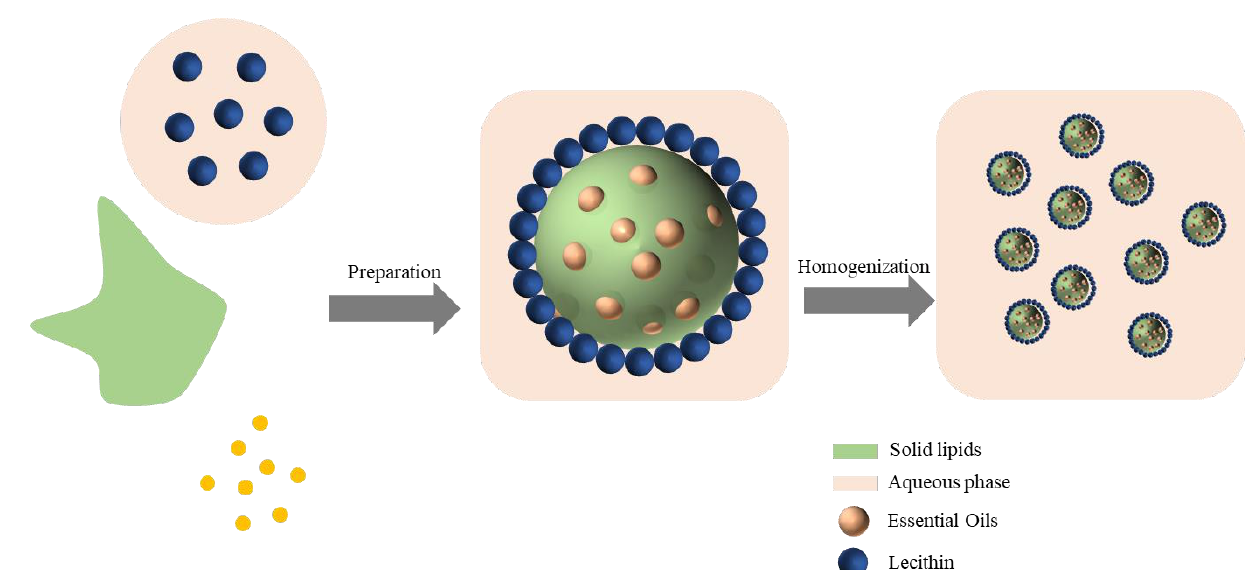
Figure 1. Chemical structure of c i nnamaldehyde.